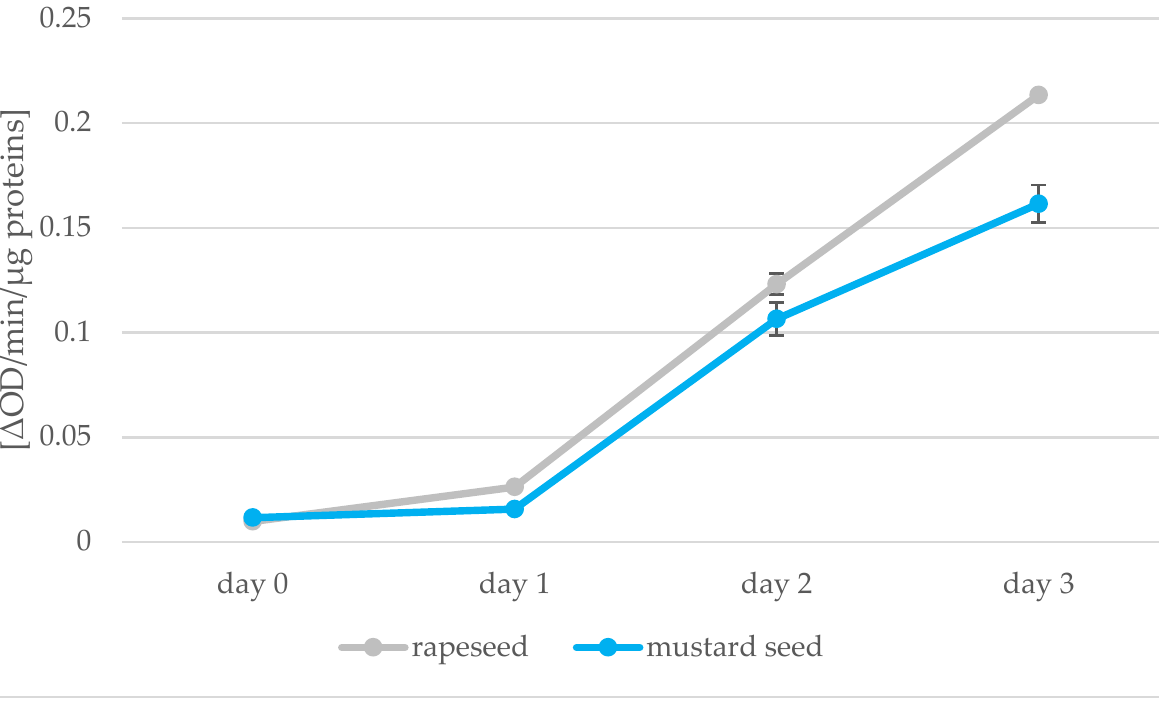
Figure 8. Peroxidase activity [ Δ OD/min/ μ g proteins] in rapeseeds and mustard seeds during germination (days 0, 1, 2, 3) (values are means ± SD from three experiments.).